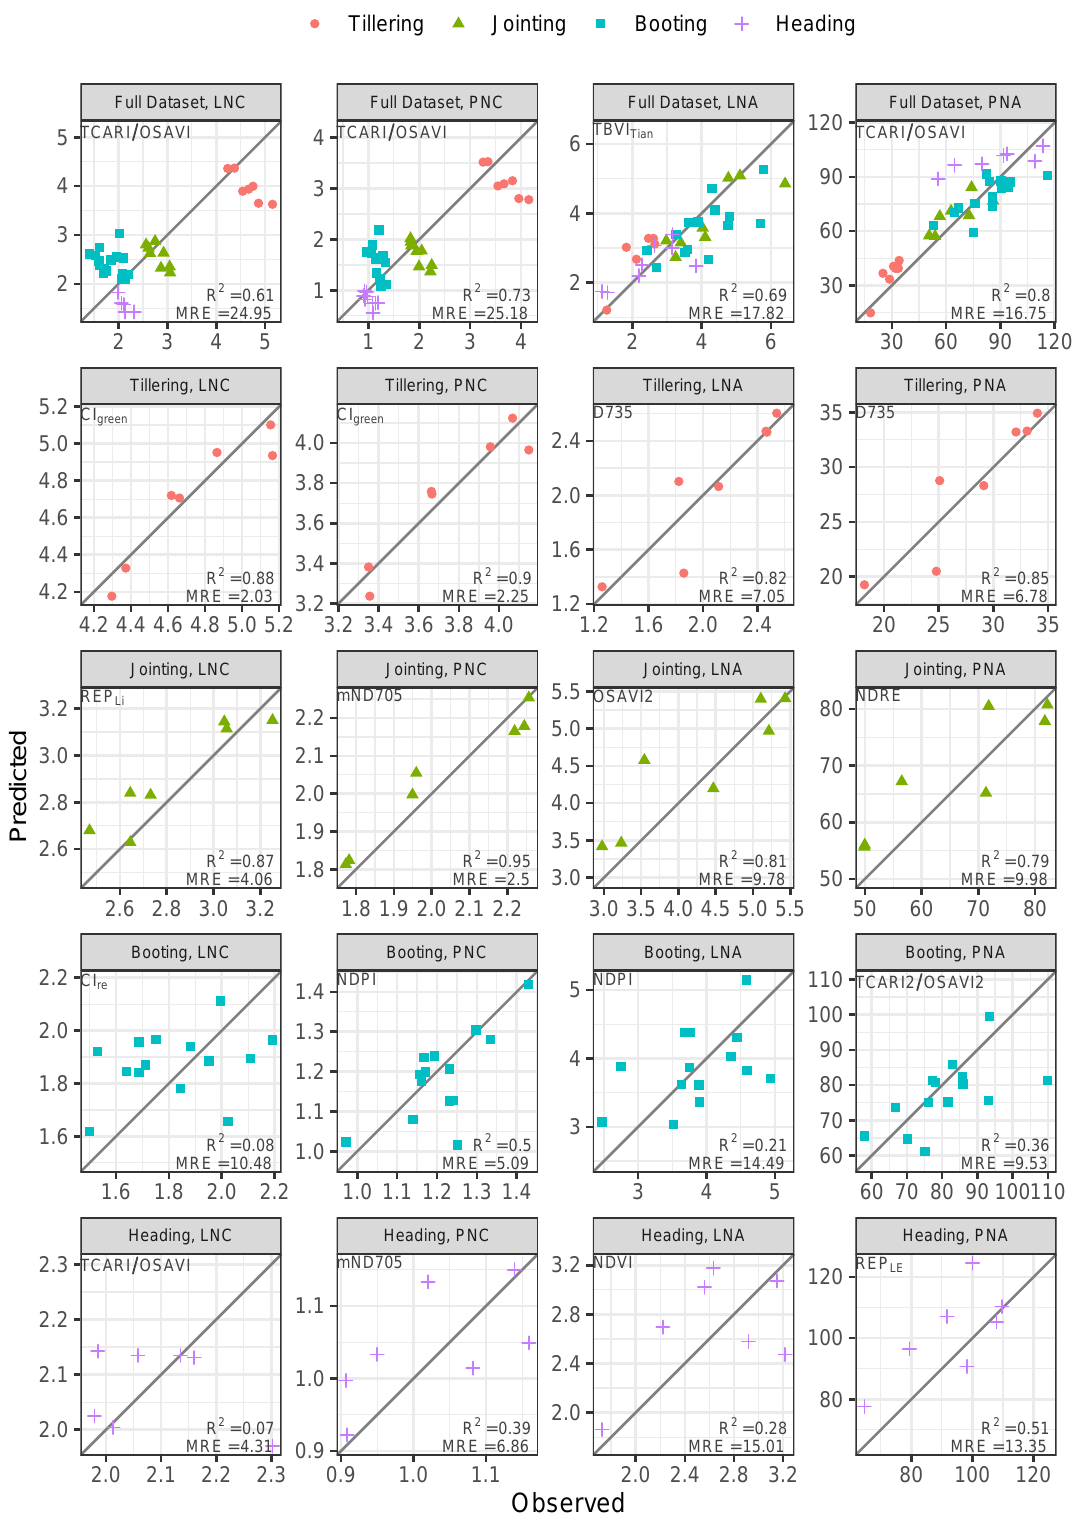
Figure 5. Scatter plots between observed and predicted nitrogen traits in the validation data set of the models listed in Table 3. The gray line is the 1:1